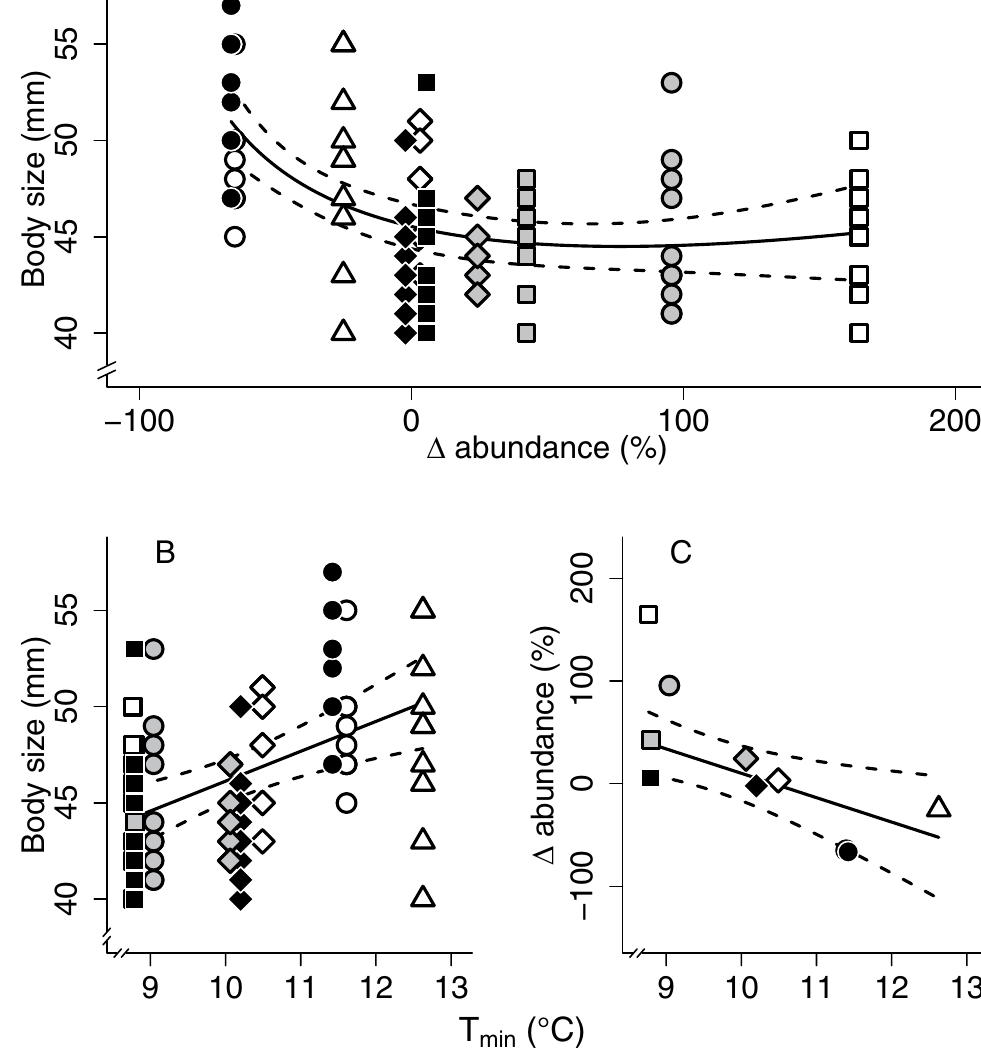
Figure 2. Natural context of population collapse in the studied populations of common lizards. ( A ) Yearlings (n = 100) grew to a larger body size (snout-vent length) in collapsing populations than in stable or increasing populations (Bas: grey circle, Bel: grey square, Car: white circle, Cha: white diamond, Com: black diamond, Jon: grey diamond, Joc: white square, Laj: black square, Mon: black circle, and Puy: white triangle). The lizard body size at the yearling stage ( B ) was positively related to minimal local temperature values (average T min , during the night), and ( C ) the relative changes in lizard abundance were negatively related with T min . In each graph, the predictions of the selected model were fitted on the data (solid line) together with the 95% confidence interval (dashed